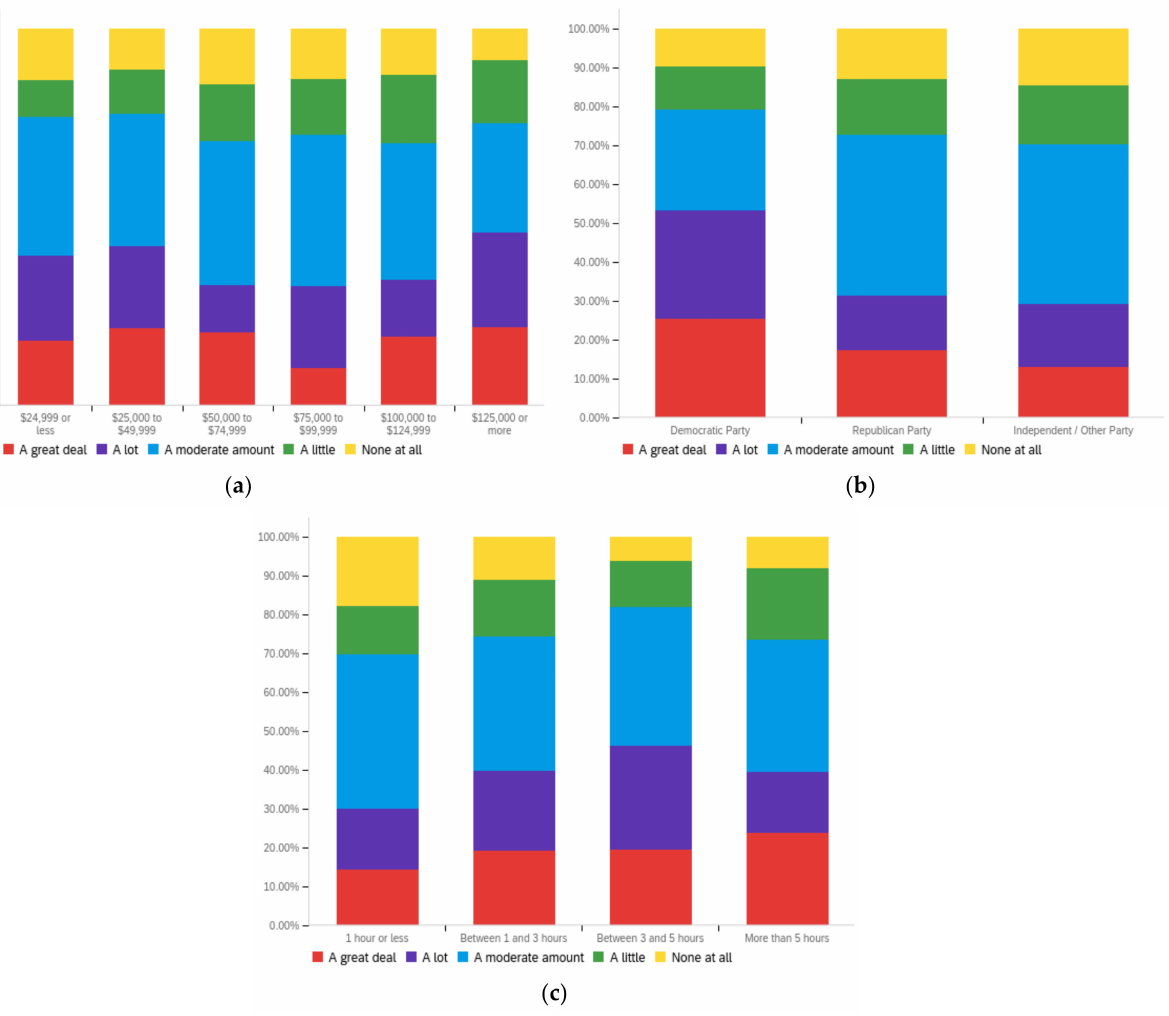
Figure A26. Article opinion statement quantity—others’ perception impact by: ( a ) income level (top left), ( b ) political affiliation (top right) and ( c ) online usage (bottom).